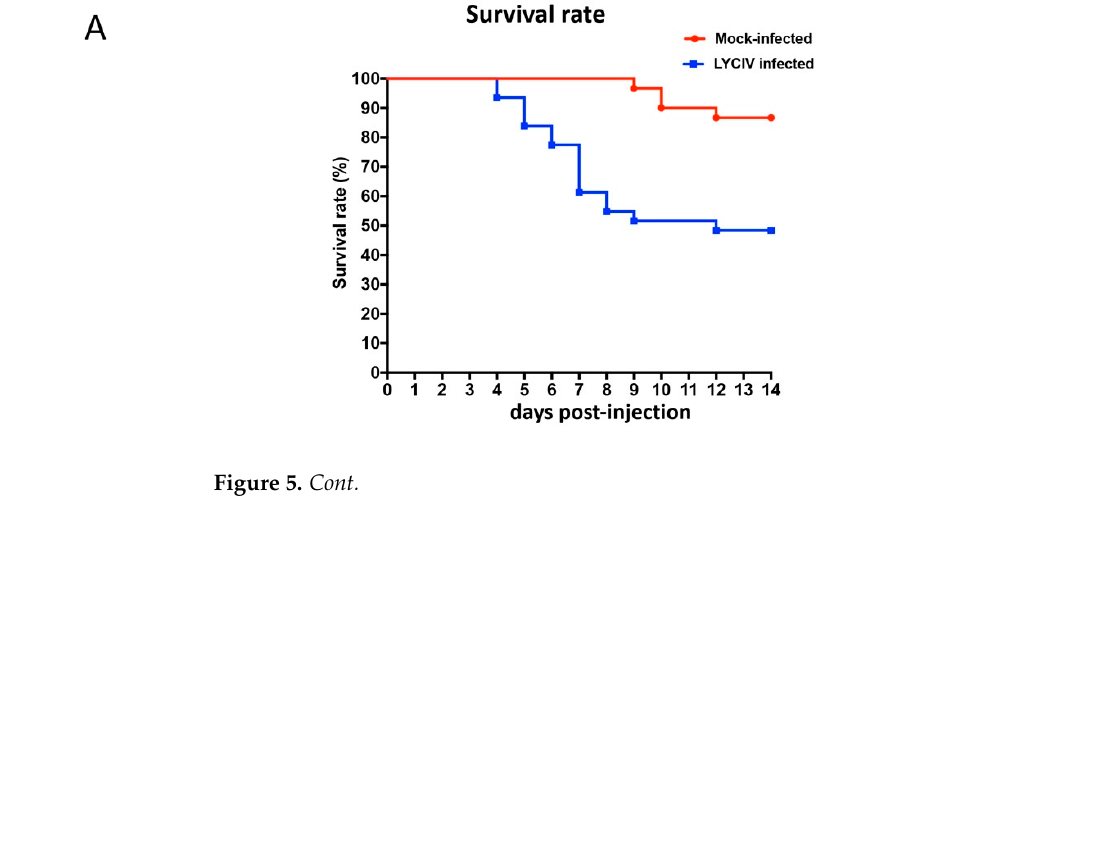
Figure 5. Pathogenicity of LYCIV-ZS-2020 on large yellow croaker. Large yellow croakers were in- fected intraperitoneally with LYCIVor HBSS. ( A ) The survival rate was calculated daily until 14 days post-injection for large yellow croakers infected with LYCIV (blue line) or HBSS (red line). Viral loads in different tissue samples, including spleen ( B ), Head kidney ( C ), gill ( D ), kidney ( E ), intestine ( F ), and liver ( G ) collected at 3, 5, 7, and 14 days post-injection were determined by qPCR and expressed as virus genome copies per milligram (mg) tissue sample. The limit of detection was 3.4 × 10 3 genome copies/mg. The error bars represent the standard deviation of the data. The blacked dotted line indicating the limit of detection (LD) 4. Discussion In this study, we obtained the full-length genome sequence of LYCIV-ZS-2020, which is the second full-length genome sequence of large yellow croaker iridovirus reported so far. The sequence similarity between LYCIV-ZS-2020 and the first reported large yellow